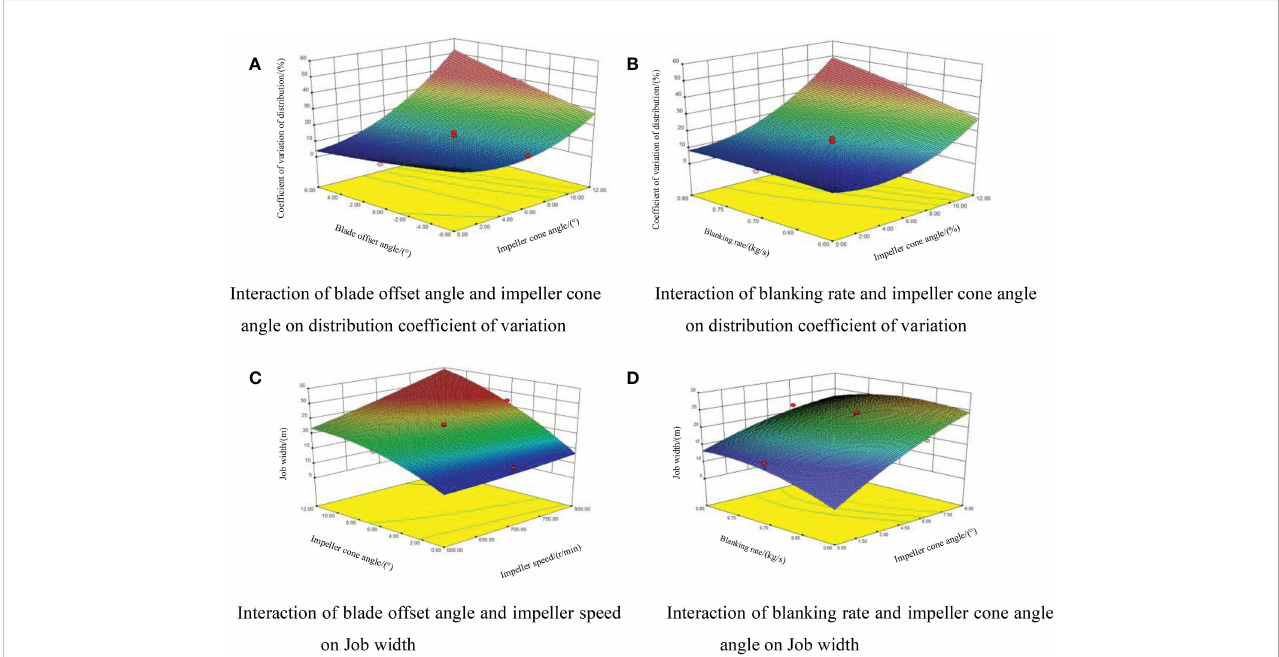
FIGURE 10 Response surface diagram. (A) Interaction of blade offset angle and impeller cone (B) Interaction of blanking rate and impeller cone angle angle on distribution coef fi cient of variation on distribution coef fi cient of variation (C) Interaction of blade offset angle and impeller speed (D) Interaction of blanking rate and impeller cone angle on Job width angle on Job